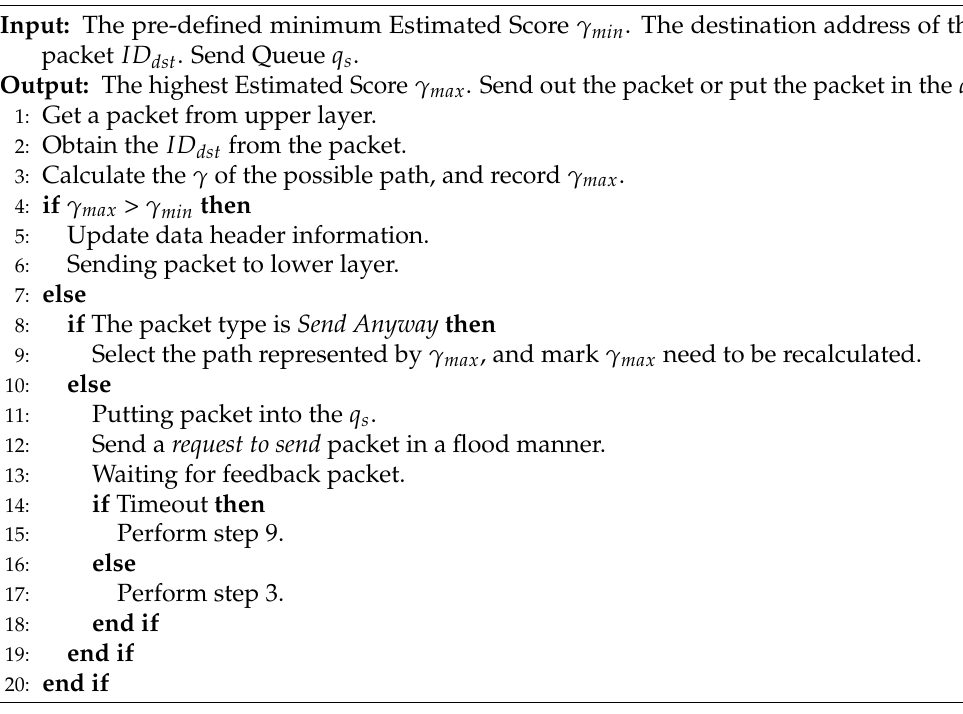
Algorithm 1 Sending side processing flow.